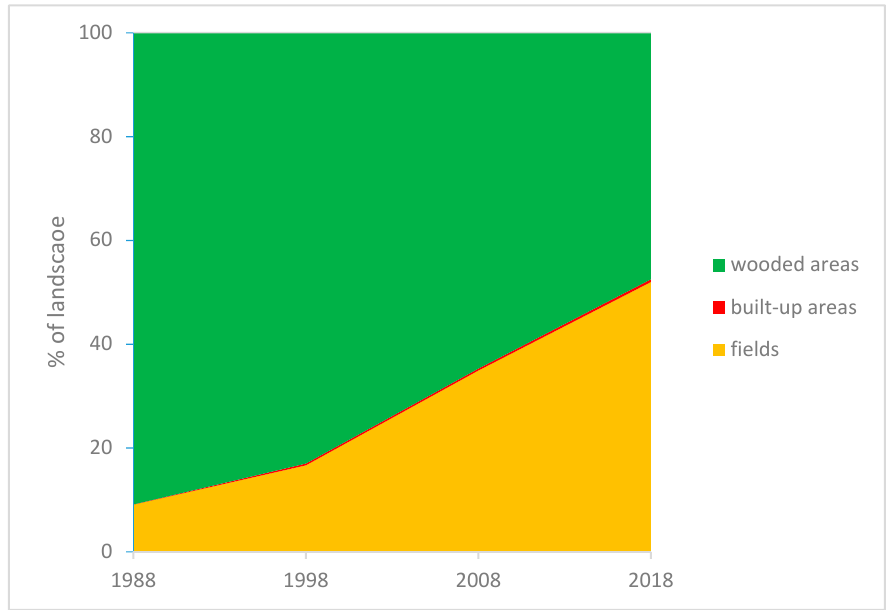
Figure 8. Evolution of landscape percentage for each land use/land cover class over time, between 1988 and 2018.